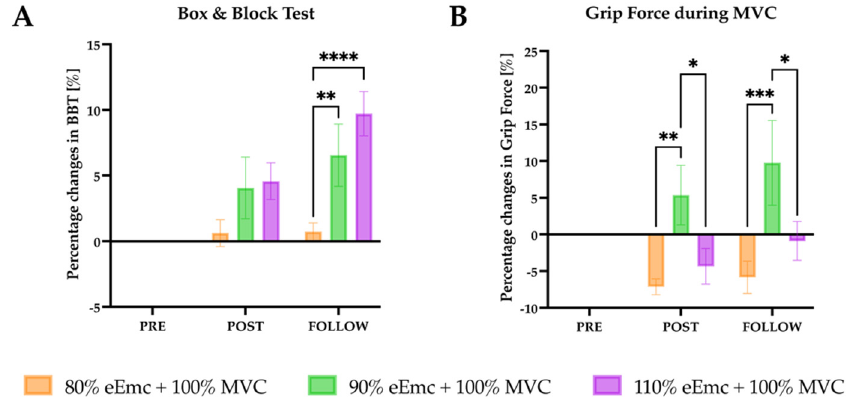
Figure 2. Functional and motor outcomes assessed by the Box and Block test and MVC. ( A ) percentage changes in the number of blocks moved in the Box and Block test with respect to baseline. Intervention simple effect shows significant differences at follow of 90% ( ** p = 0.004) and 110% eEmc ( **** p < 0.0001) with respect to 80% eEmc; ( B ) percentage changes in MVC with respect to baseline. Intervention simple effect showed differences of 90% eEmc compared with 80% ( ** p = 0.0026) and 110% eEmc at post ( * p = 0.0211) and follow ( *** p = 0.0108; * p = 0.0002) time points.